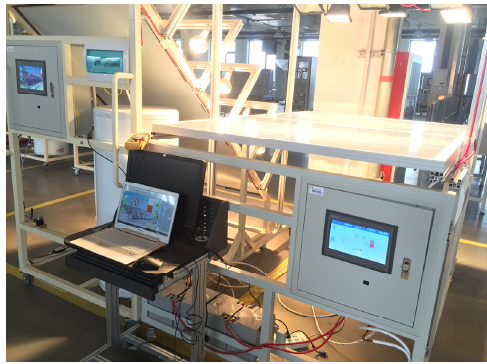
Figure 2. A photograph of the proposed system.